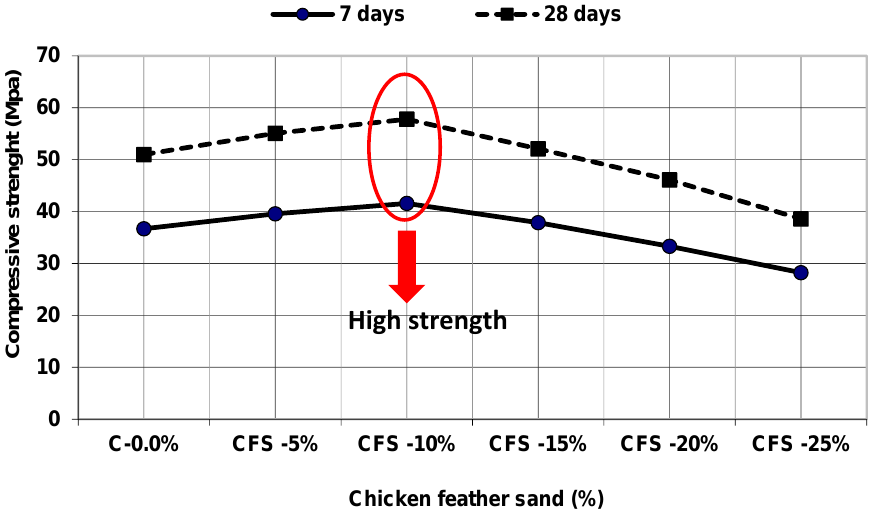
Figure 10. The values of compressive strength at 7 and 28 days for all mixtures.